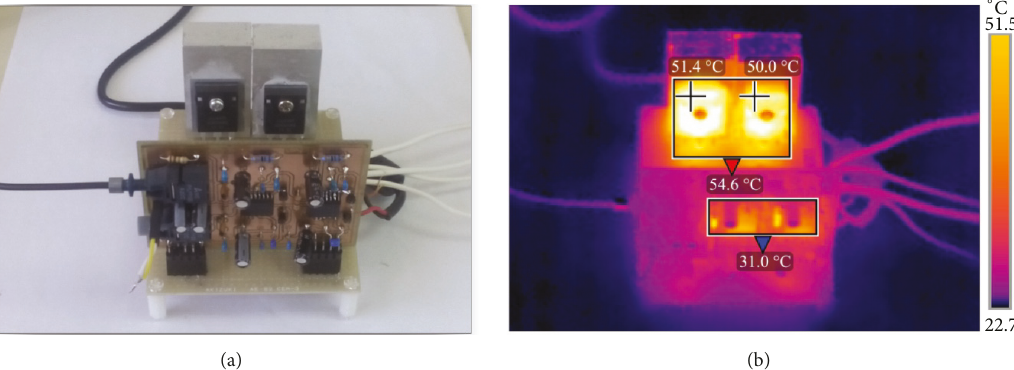
Figure 10: Thermal image of the Bi-Sw running at 𝑉 𝑆 = 220 V, 𝑖 𝐿 = 6A, 𝐹 𝑆𝑊 = 100kHz, and 50% duty cycle. The SiC-MOSFETs are shown to be the hottest part at 54.6 ∘ C. (a) Digital image. (b) Thermal